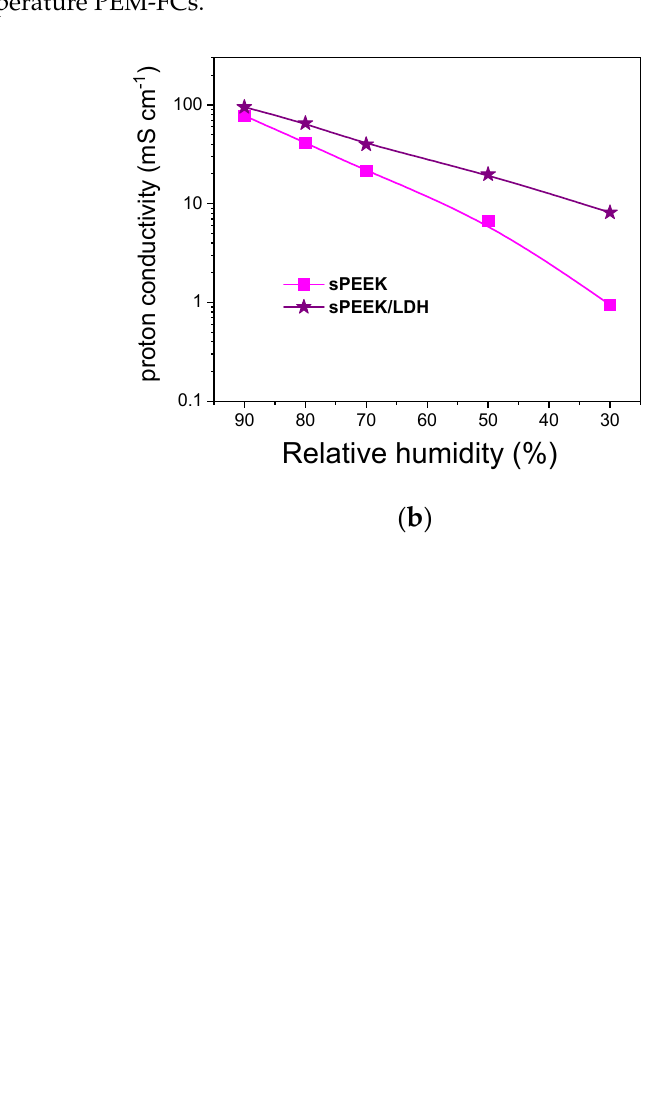
Figure 9. Proton conductivity vs. relative humidity at 90 °C for ( a ) Nafion and Nafion/LDH, ( b ) sPEEK and sPEEK/LDH, and ( c ) sPSU and sPSU/LDH membranes.